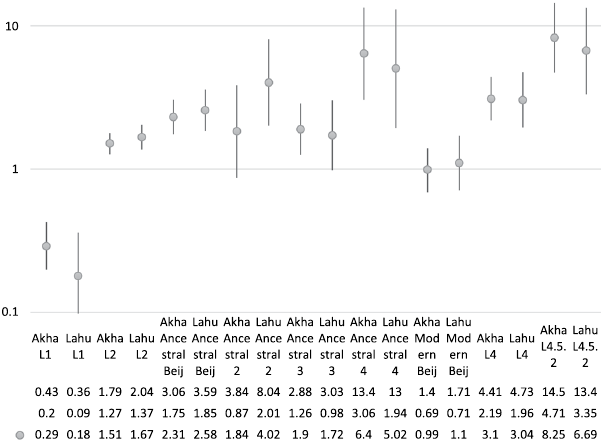
Figure 2. The risk ratios, of which the mean values are presented by grey dots with the lines showing 95% confidence intervals, of Akha and Lahu tribes compared to Thais for infections with some selected lineages and sublineages of M . tuberculosis . The Y axis is on a logarithmic scale. The vertical lines that intersect the horizontal line 1 indicate statistically non-significant risk-ratios. The risk ratios for L1 were much lower than one while the reverse was true for L2 and L4. The highest risk ratios were observed for L2.2.1.Ancestral 4 and